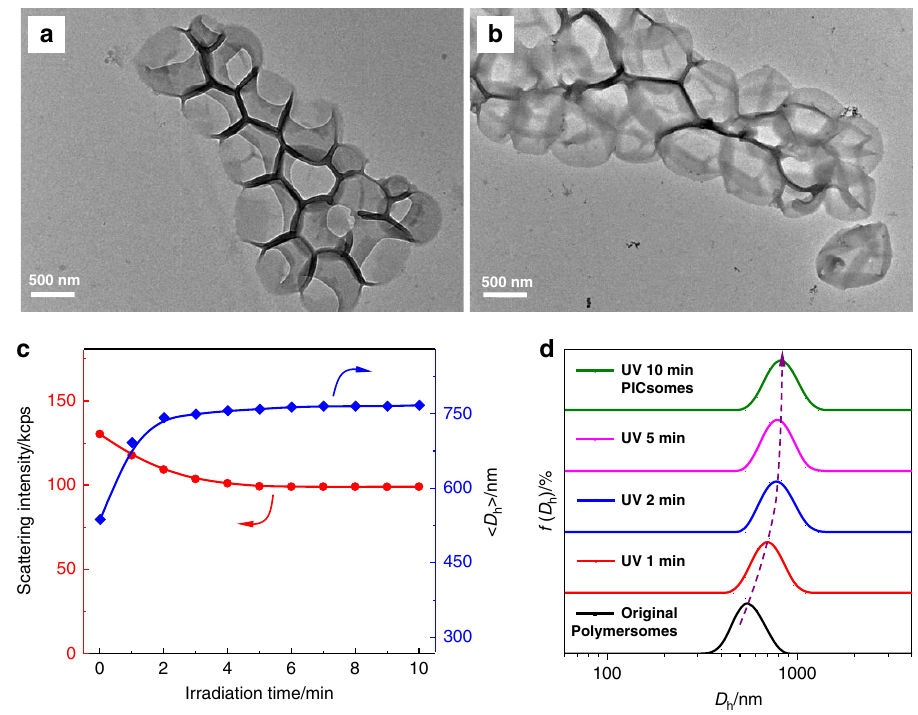
Fig. 8 Light-triggered microstructural evolution of triblock copolymer vesicles. TEM images of PEO 45 - b -PNCMA 17 - b -PDPA 21 polymersomes a and corresponding PICsomes b . c Irradiation duration-dependent evolution of scattered light intensities and 〈 D h 〉 recorded during polymersome-to-PICsome transition for PEO 45 - b -PNCMA 17 - b -PDPA 21 vesicles in neutral aqueous media. d Evolution of intensity-average D h distributions upon UV irradiation. All scale bars are 500 nm. All data were obtained at a polymer concentration of 0.1 g/L in neutral aqueous